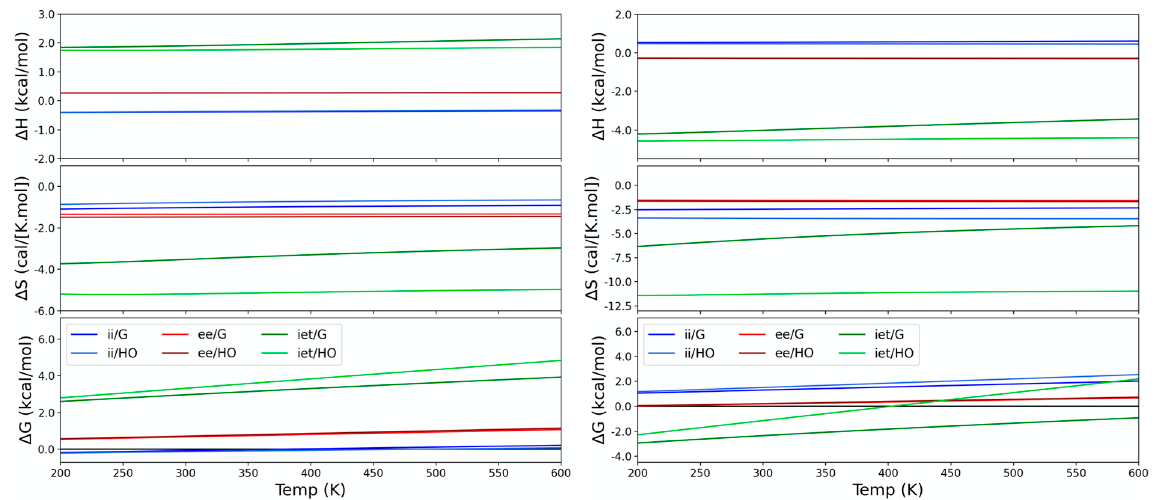
Figure 4. Thermodynamic functions for the corannulene pincer conformers with respect to species ie . Data generated from the PM6-D3H+ ( left ) and GFN2-xTB ( right ) calculations.